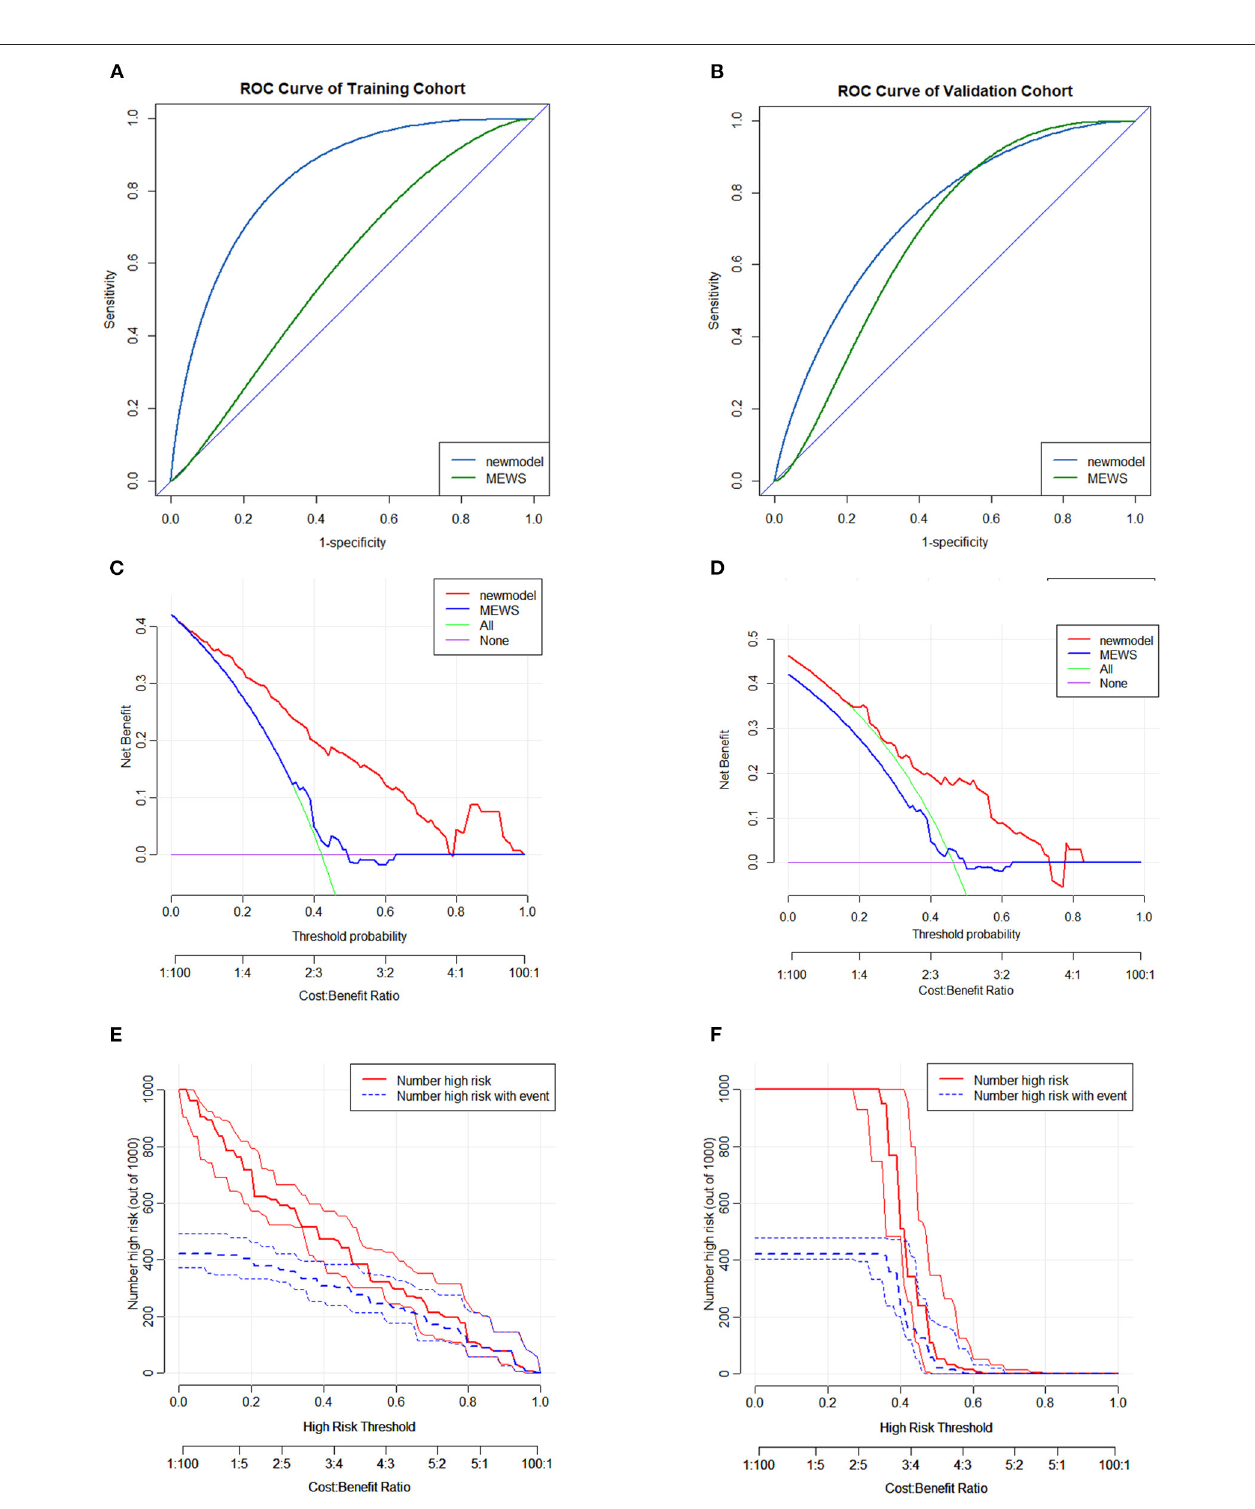
FIGURE 3 | Discrimination and clinical effectiveness validation of predicting nomogram model. The ROC analyses of in-hospital mortality of the nomogram model and MEWS in the training cohort (A) and validation cohort (B) . DCA curve for in-hospital mortality in the training cohort (C) and validation cohort (D) . CIC for in-hospital mortality in nomogram model (E) and MEWS (F) in the training cohort. CIC, clinical impact curve; DCA, decision curve analyses; MEWS, Modified Early Warning Score; ROC, receiver operating characteristic curve.